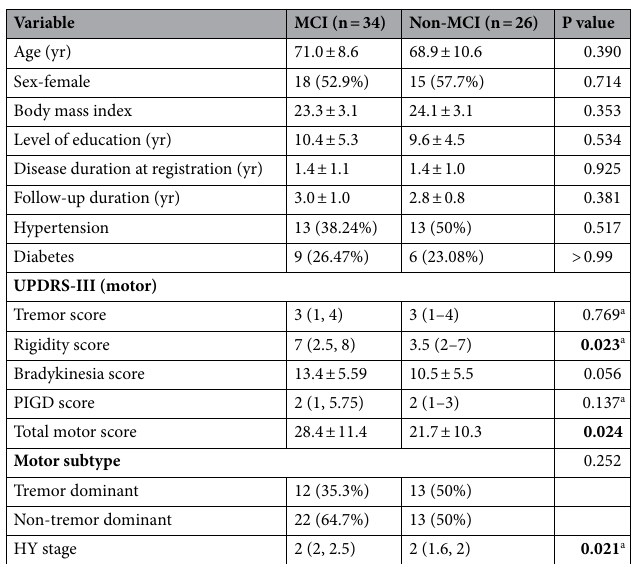
Table 1. Demographics and motor symptoms in de novo Parkinsonian patients with or without MCI. Data are presented as n (%) for categorical variables or mean ± S.D./median (interquartile range) values for continuous variables. MCI, mild cognitive impairment; UPDRS, Unified Parkinson’s disease rating scale; PIGD, postural instability and gait difficulty; HY, Hoehn and Yahr. Statistical analyses were conducted with Chi square test for categorical variables, Student t-test or Mann–Whitney U test a for continuous variables. Significant values are in